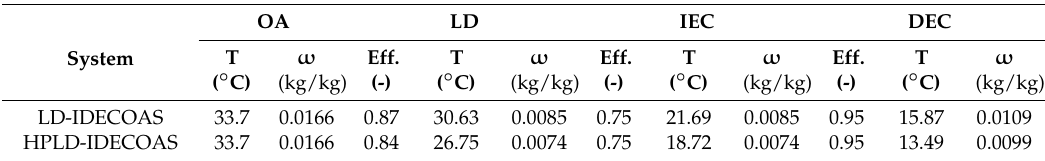
Table 5. Air condition changes in the system.